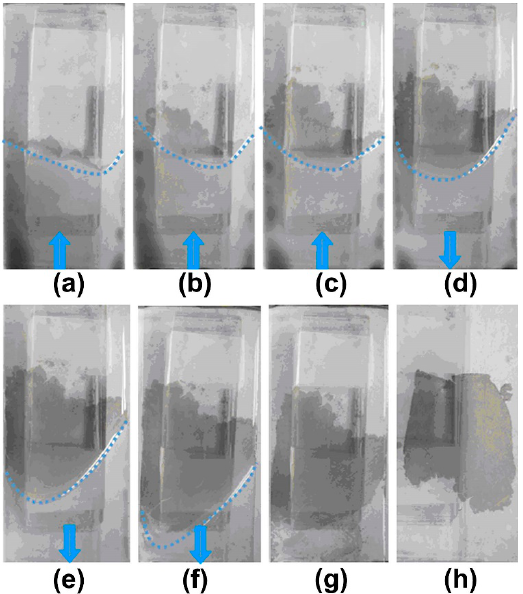
Figure 4. The self-assembly process of CS solution with the concentration of 0.2% wt/mL: ( a ) 10 s, ( b ) 30 s, ( c ) 60 s, ( d ) 120 s, ( e ) 180 s, ( f ) 240 s, ( g ) 360 s, ( h ) 600 s.